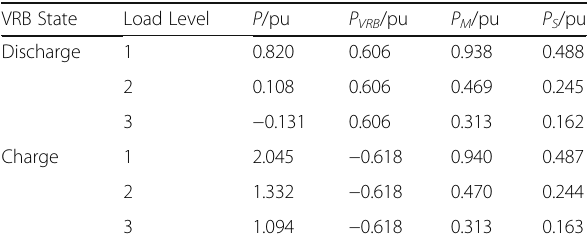
Table 4 Six different load